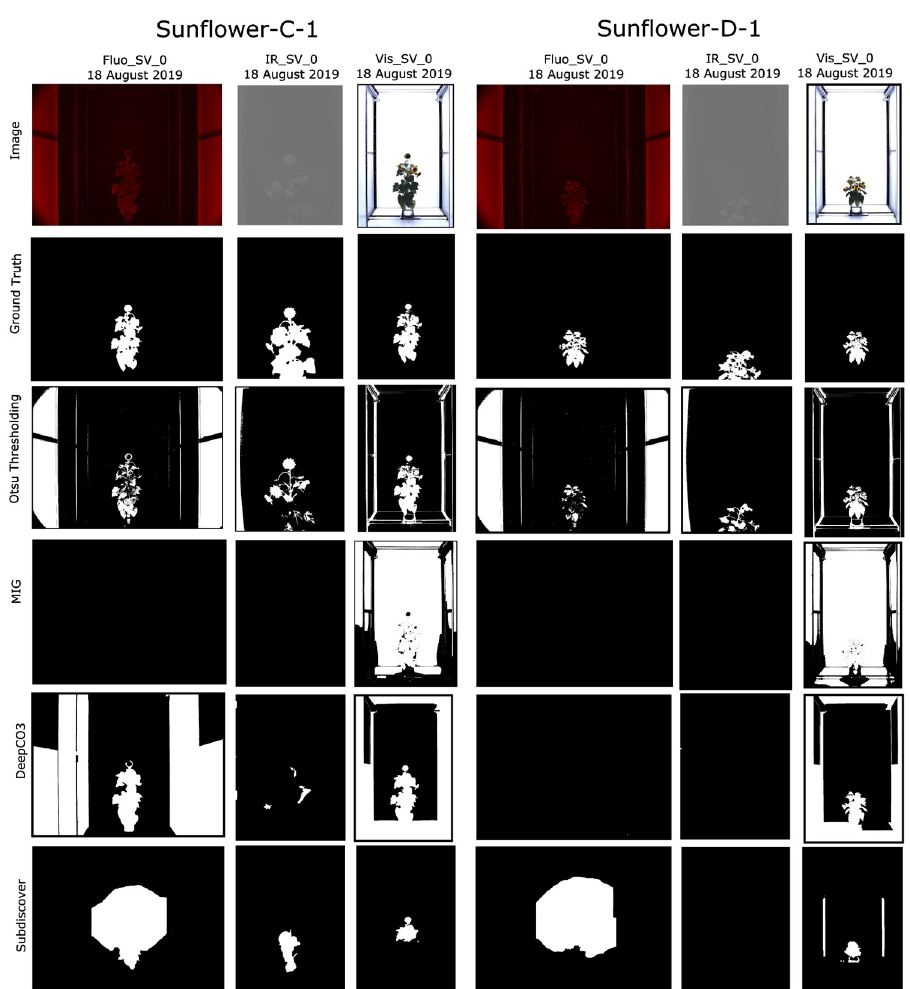
Fig 6. Qualitative performance examples of CosegPP ’s Sunflower with three cosegmentation methods (DeepCO 3 , MIG, Subdiscover) and one plant phenotyping segmentation methods (Otsu Thresholding). Each binary mask produced is the output of each cosegmentation methods with CosegPP where the white pixels are the pixels for the identified